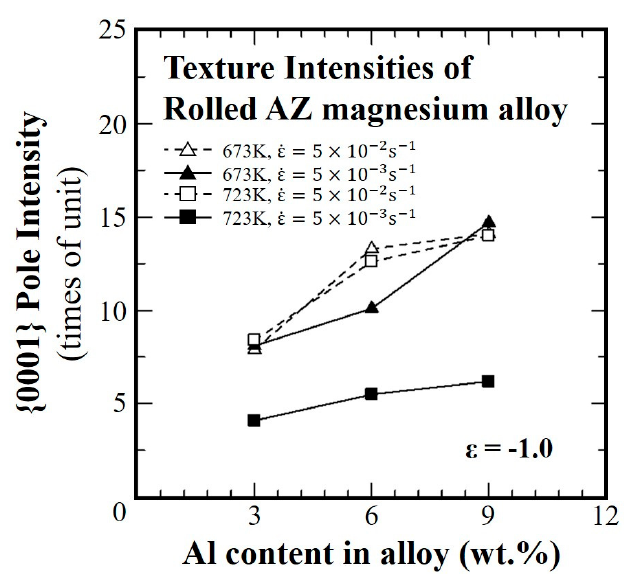
Figure 10. Aluminum concentration dependence of the pole densities at temperatures of 673 K and 723 K under strain rates of 5.0 × 10 − 2 s − 1 and 5.0 × 10 − 3 s − 1 up to a strain of − 1.0.